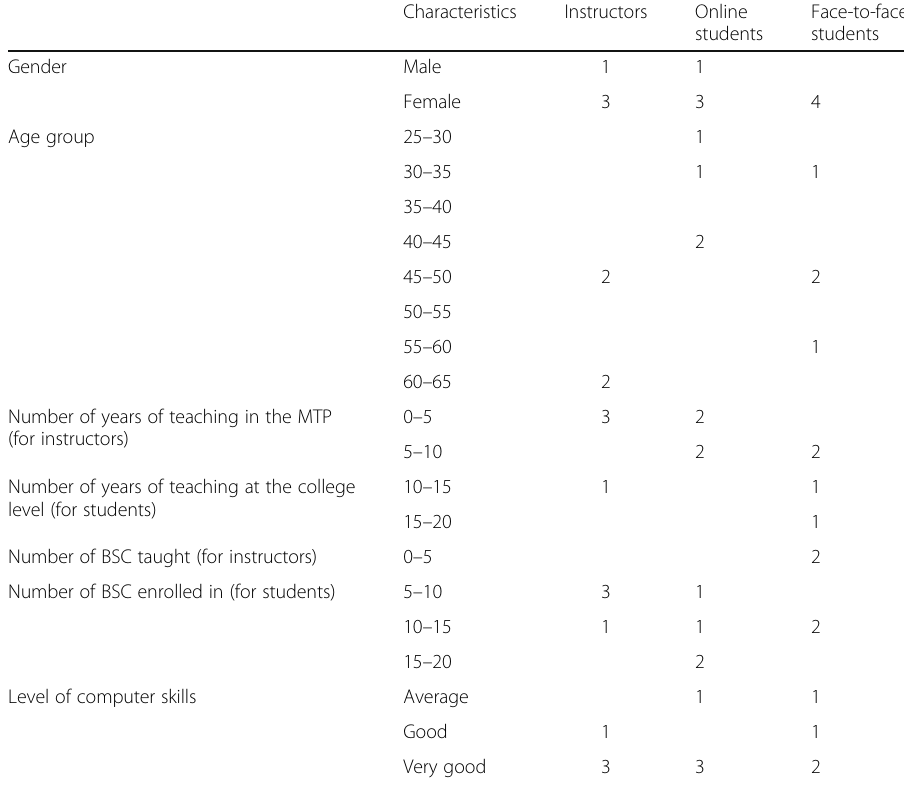
Table 1 Demographic details of the study